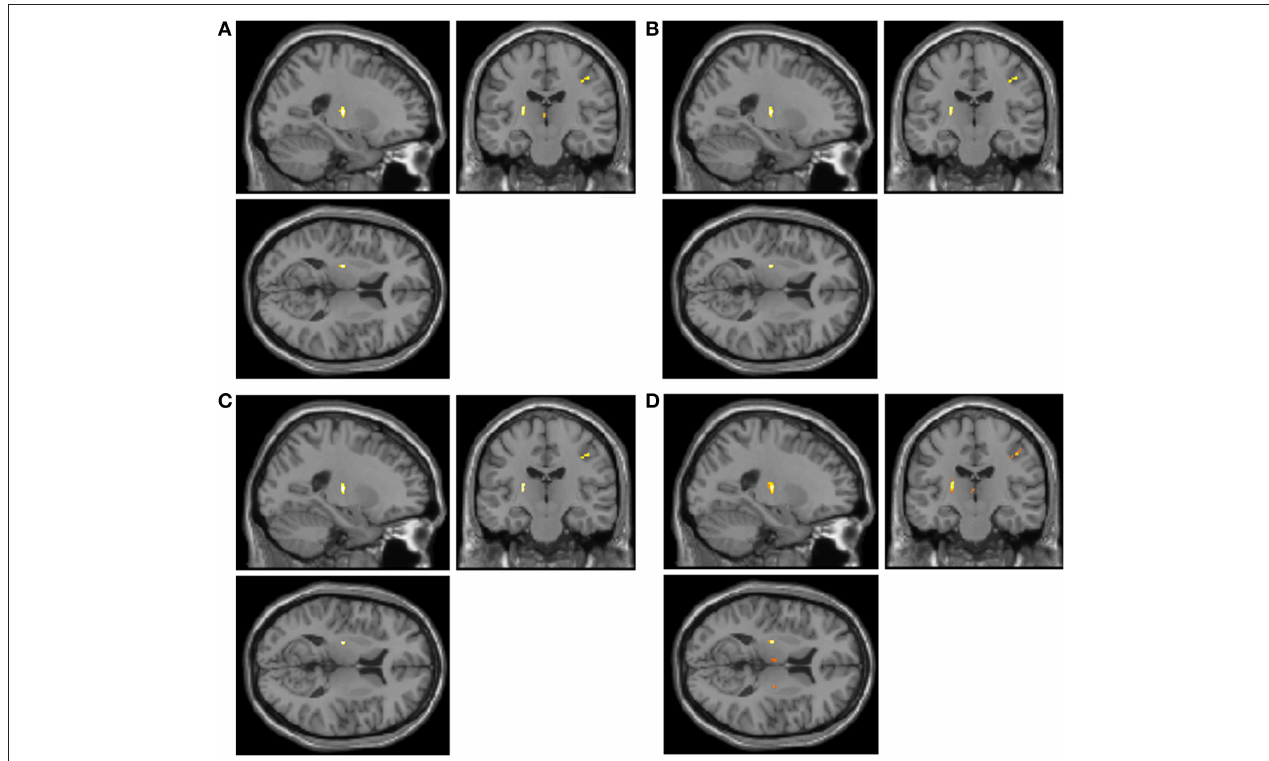
FIGURE 1 | Statistical parametric maps of texture changes overlayed on a T1-weighted image reveal differences predominantly in the precentral gyrus and corticospinal tract in all 4 texture features: autocorrelation (A, Auto), sum average (B, Savg), sum of squares variance (C, Sosv), and sum variance (D,